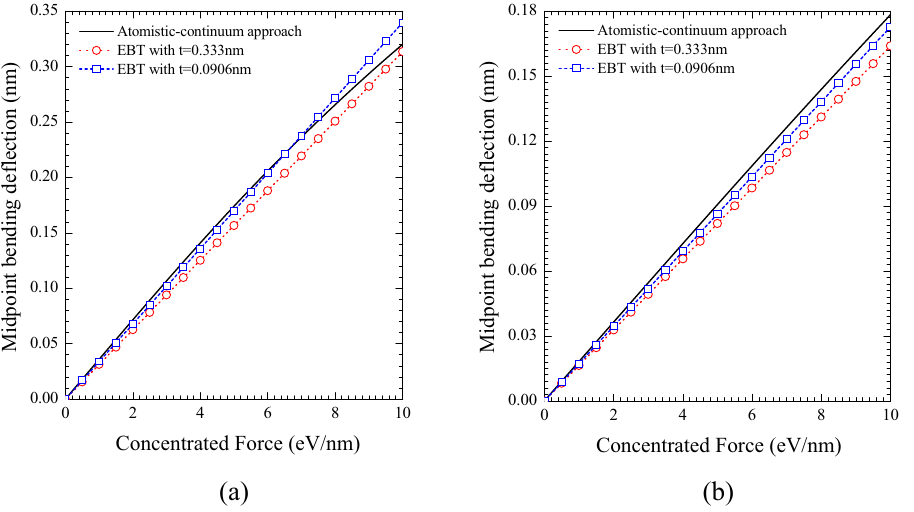
Figure 3: The midpoint bending de fl ection of 12 nm long ( 8, 8 ) ( a ) and ( 10, 10 ) ( b ) BNNTs with simply supported constraint versus external transverse force. A nonlinear relation between transverse load and bending de fl ection is observed.